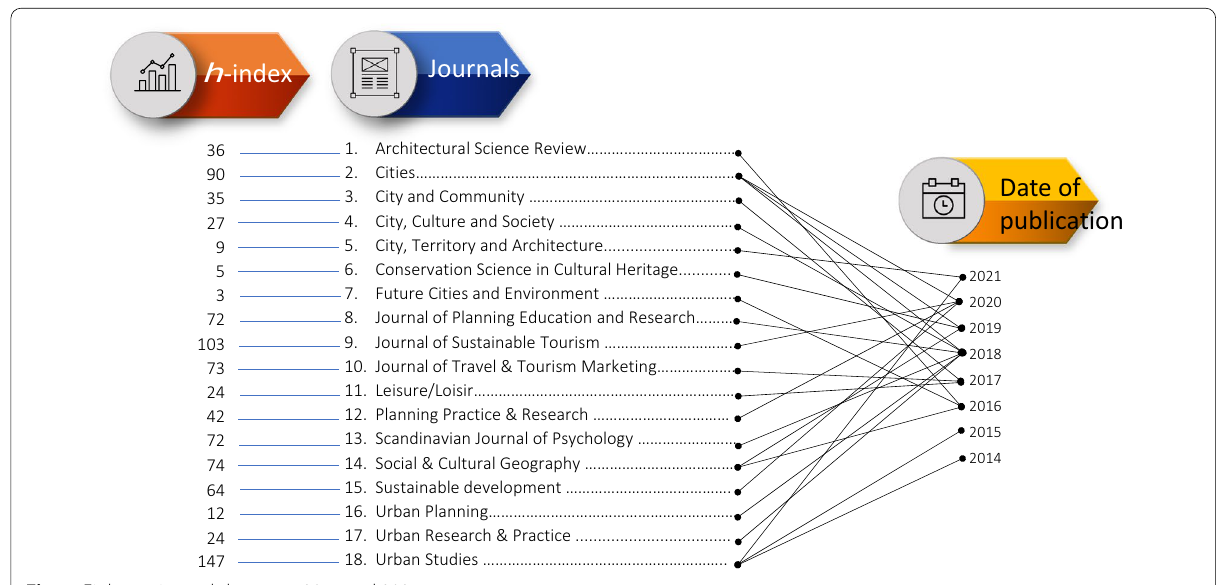
KEY (guidance AND for AND practitioners)].